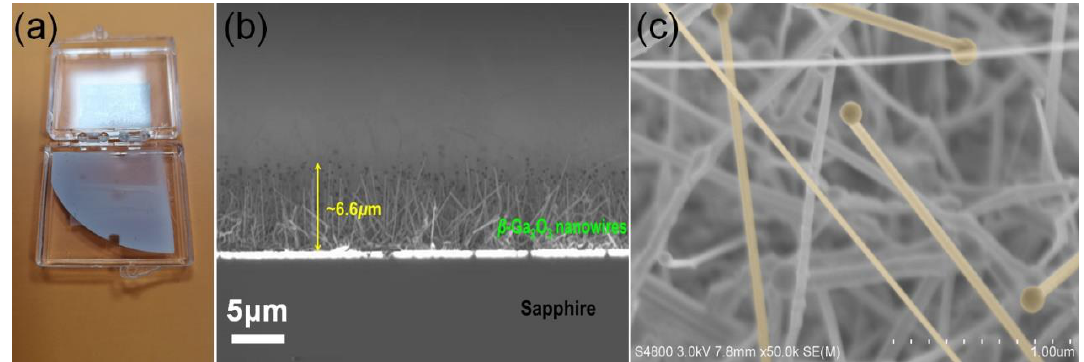
Figure 3. ( a ) A quarter of 2-inch as-grown β -Ga 2 O 3 nanowires on sapphire wafer. ( b )